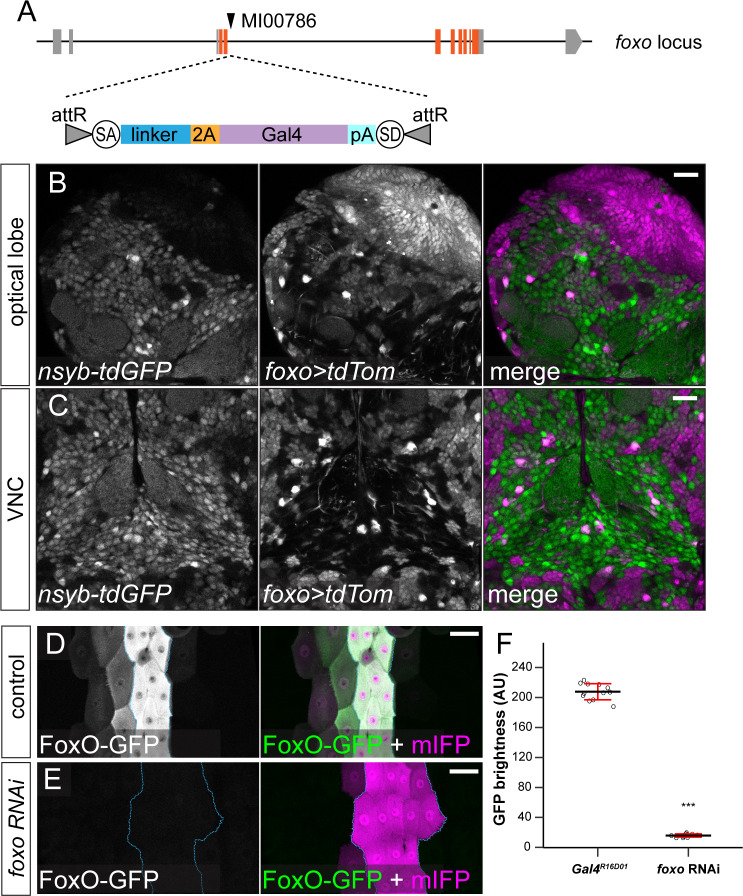
foxO-Gal4 and effectiveness of foxo RNAi.(A) Diagram of foxO-Gal4. (B and C) Gal4foxo-driven tdTom expression in optical lobe (B) and VNC (C) in LY condition. (D and E) UAS-FoxO-GFP in Gal4R16D01 control (D) and animals co-expressing foxo RNAi (E). The Gal4R16D01 domain is outlined. (F) Quantification of FoxO-GFP levels in control and foxo RNAi animals. Each circle represents a segment; n = 12 for control and foxo RNAi. ***p<0.001; Student's t-test. Black bars, mean; red bars, SD. Scale bars, 20 μm in (B) and (C), 50 μm in (D) and (E).